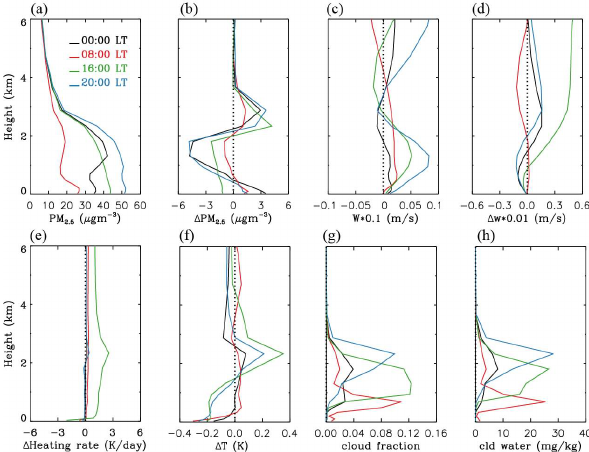
Fig. 6. Vertical distribution of monthly/domain averaged variables over the smoke source region in October 2006 at different local times for (a) PM 2 . 5 concentration, (b) difference of PM 2 . 5 con- centration ( 1 PM 2 . 5 ), (c) vertical velocity ( w ), (d) difference of w ( 1w ), (e) difference of heating rate, (f) difference of air temperature ( 1T ), (g) cloud fraction, and (h) cloud water. The difference of each variable ( 1V ) is defined as 1V = V Ra − V non-Ra . The OC/BC ratio is 10 in the simulation. The smoke source region is the area where the monthly averaged AOD is larger than 0.5 (Fig.